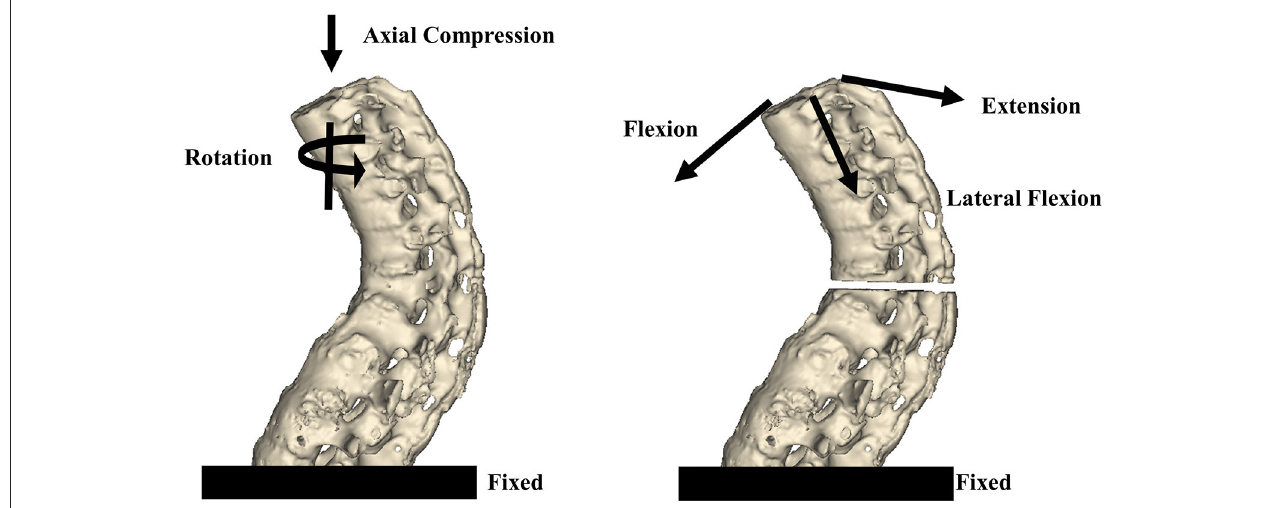
FIGURE 1 | The thoracolumbar AS spine model from T8 to L4 was created on the basis of a CT scan. To simulate an unstable three-column thoracolumbar fracture, a horizontal osteotomy with a 5mm bone defect at T12 was performed. An axial force and torsion were applied to all models. For the axial force, 300N was applied to T8 and vertically downward in the coronal and sagittal planes. For torsion, a 10-Nm torque was applied to T8 around the vertical axis. To simulate flexion/extension and lateral flexion, a 10-Nm torque was applied to T8 toward the front/rear and side orientations.